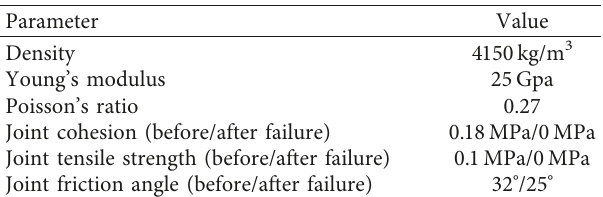
Figure 12: Stope layout and the DDA Model. (a) Layout of the stope structure on the A–A measurement points. (c) DDA model. Table 3: Physical parameters of the